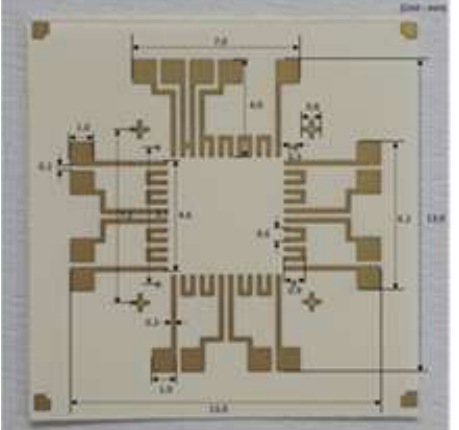
Figure 1. Daisy chain pattern on a polyimide substrate.